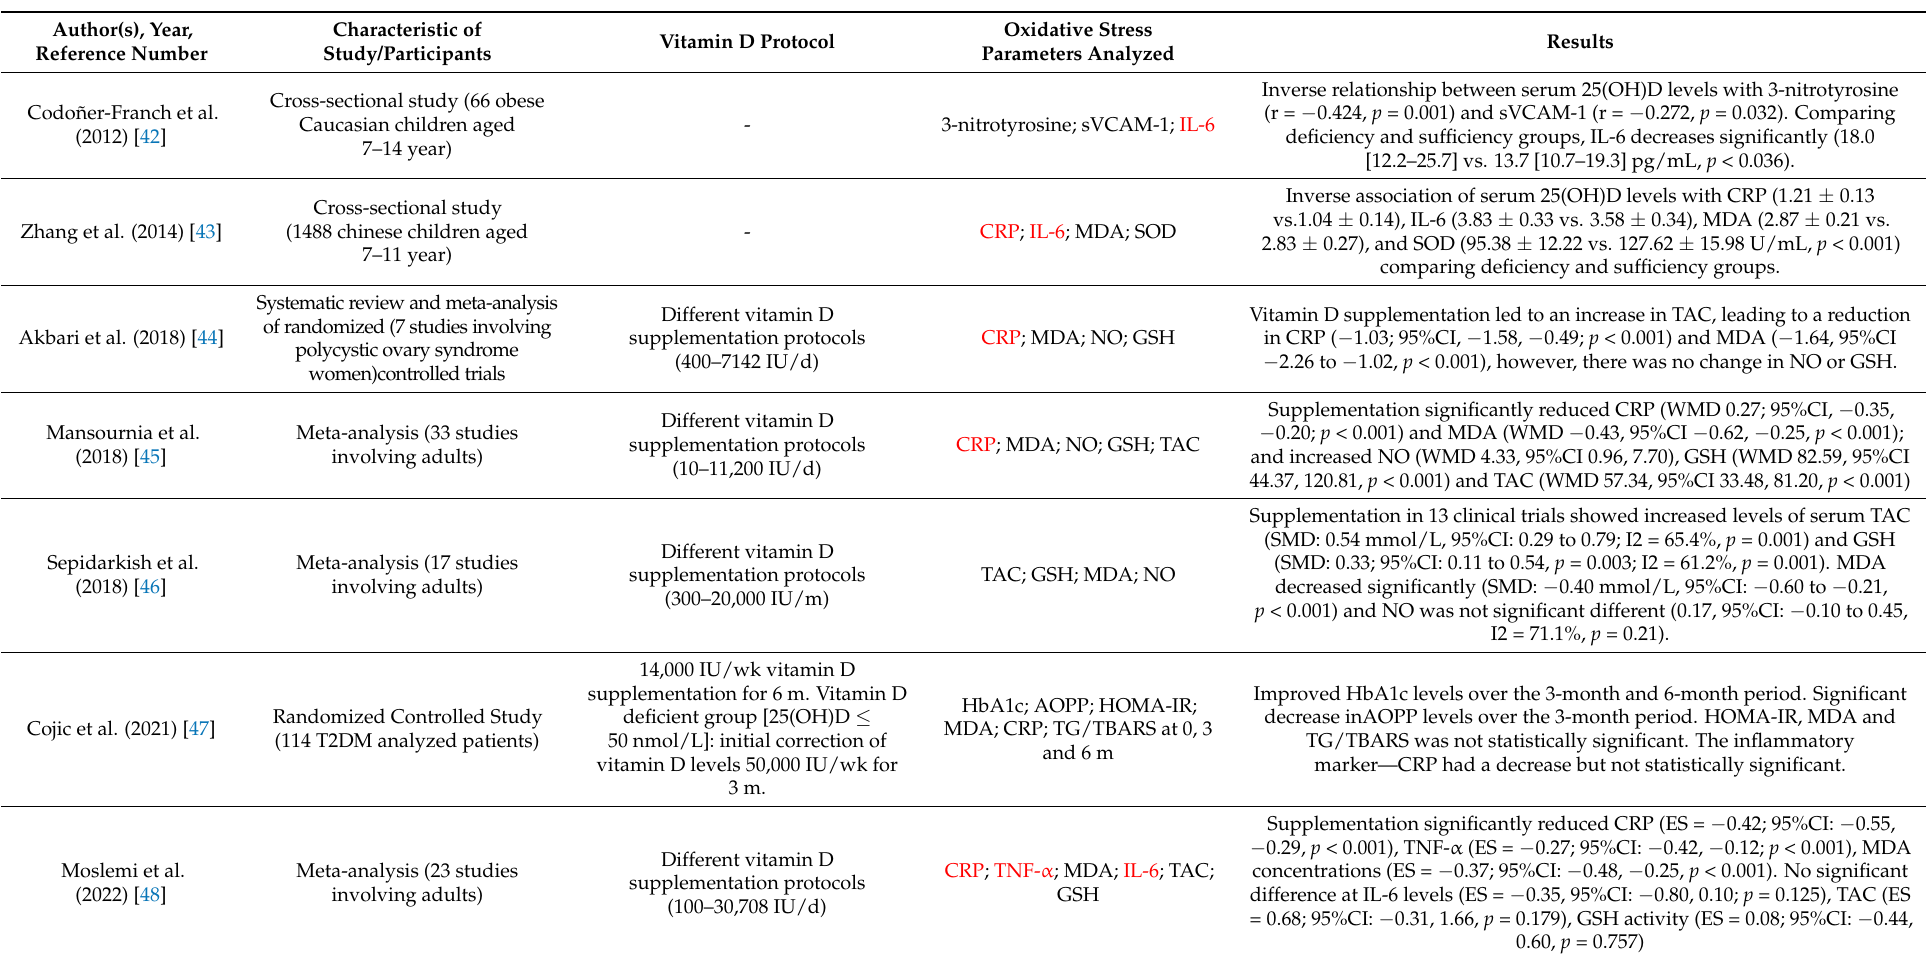
Table 1. Vitamin D, oxidative stress and inflammation